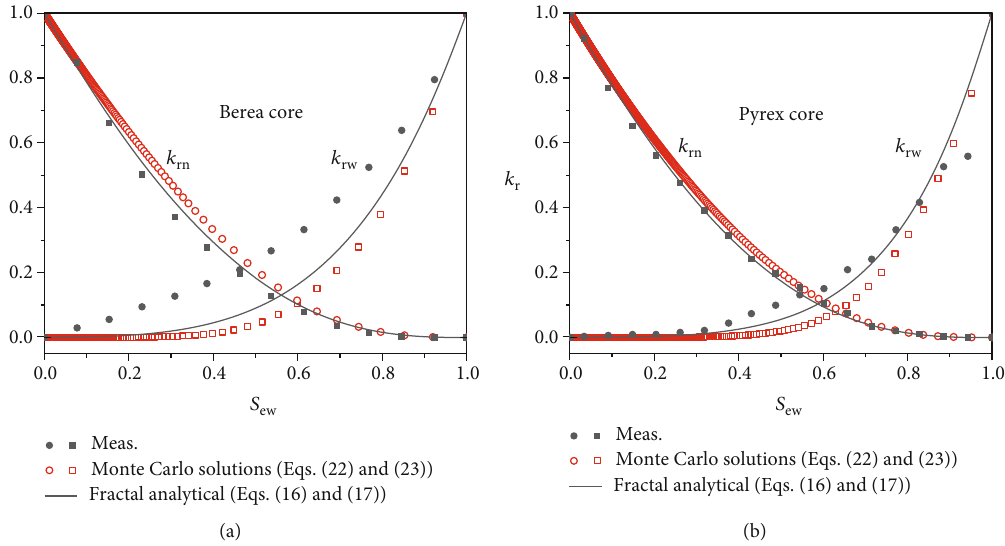
Figure 5: Predicted relative permeability for (a) water-nitrogen system and (b) water-steam system as well as the comparison to the experimental